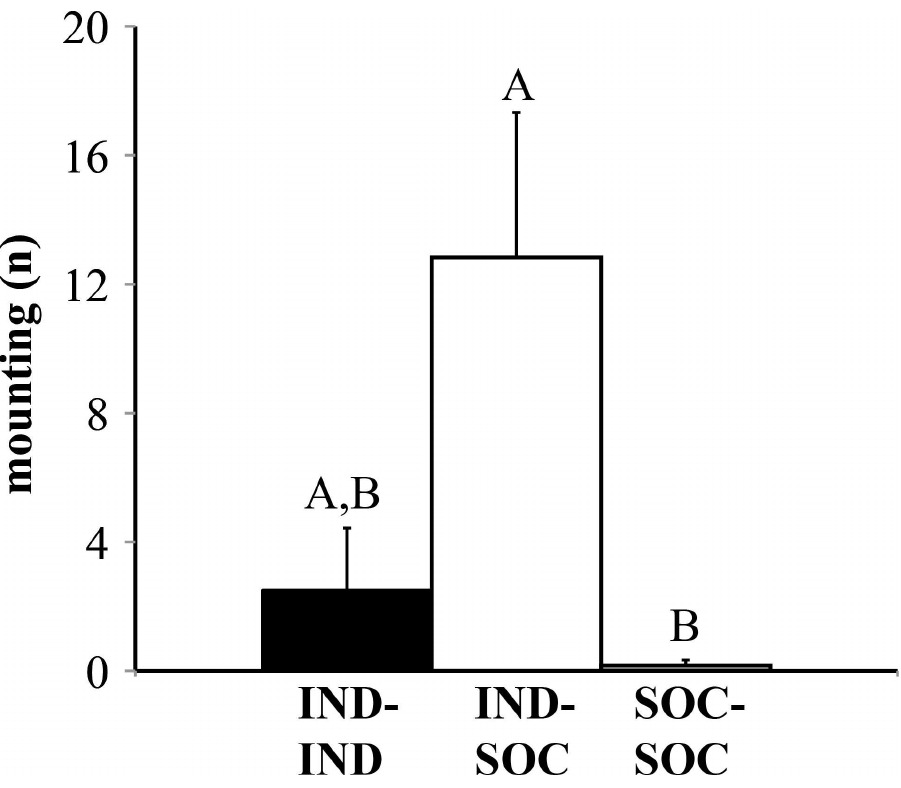
Fig 6. Number of mounting occurrences performed by pairs of male mice with different social histories. For IND-SOC pairs, IND males mounted SOC males. Bar heightsrepresent means ± S.E.M; bars with different letters are statistically different (Kruskal-Wallis test with Bonferroni post-hoc tests, p < 0.05). IND = individually housed male; SOC = sociallyhoused male. See methods for additionaldetailsregarding